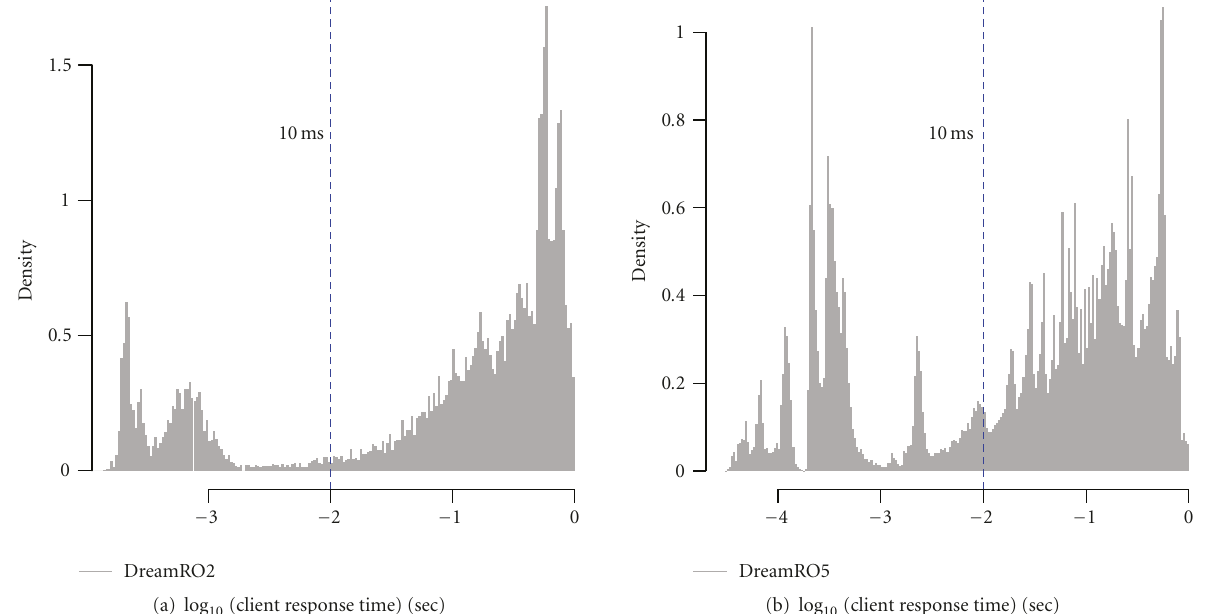
Figure 7: Histograms of client response times in two DreamRO traces. More than one peak is formed at time scales smaller than 10 milliseconds. Peaks do not occur in player traces or Kore